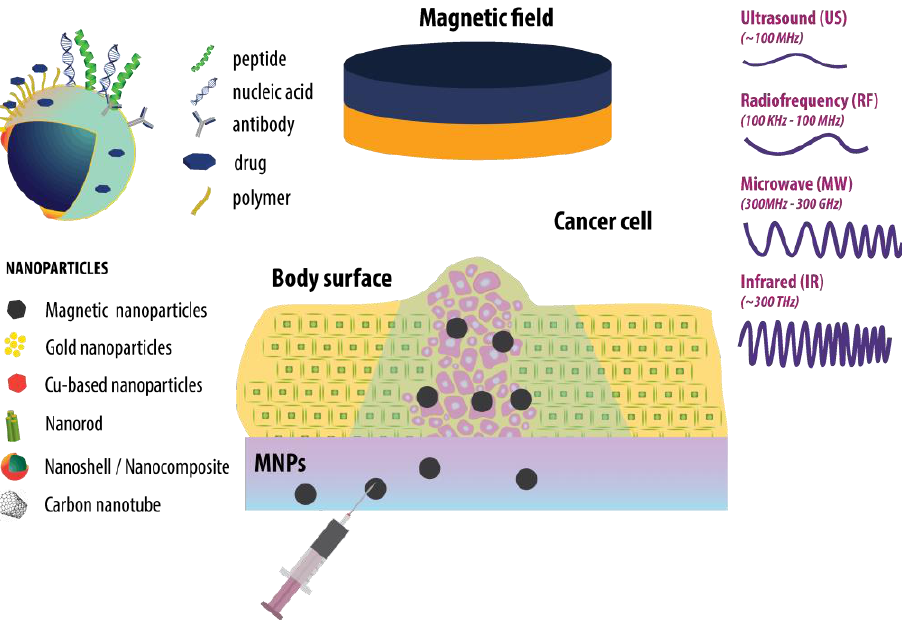
Figure 2. Schematic representation of cancer thermal therapy using the combination of nanomaterials with various surface functionalization possibilities and different external heat sources.